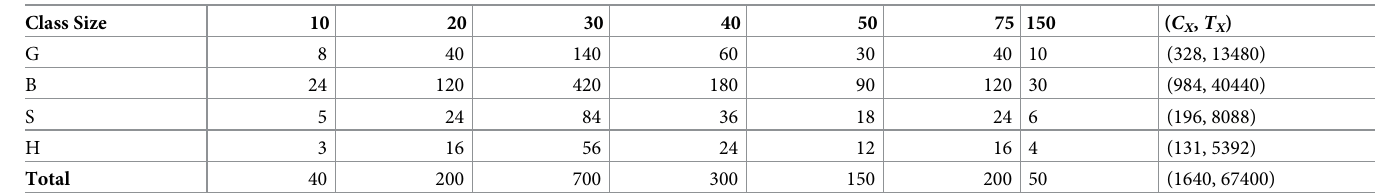
Table 2. Counts for various class